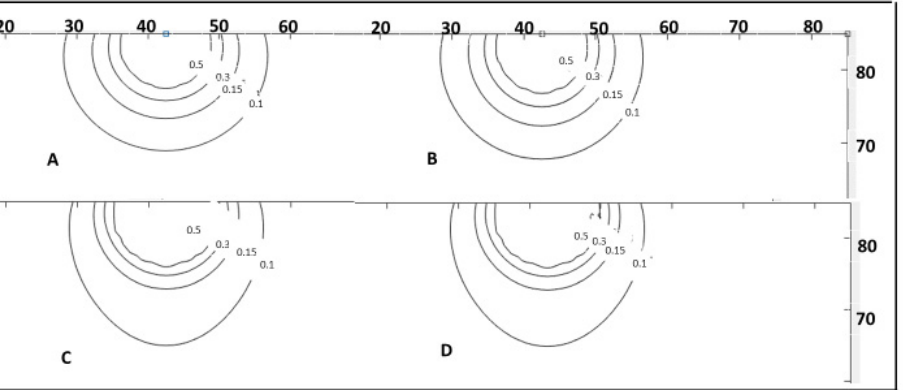
Figure 3. Soil water content under non evaporative infiltration from surface drip (DI). ( A ) 500, ( B ) 1000, ( C ) 2000 and ( D ) 3000 cm 3 hr (cid:3119) . Values on axes are vertical and horizontal distances (cm).